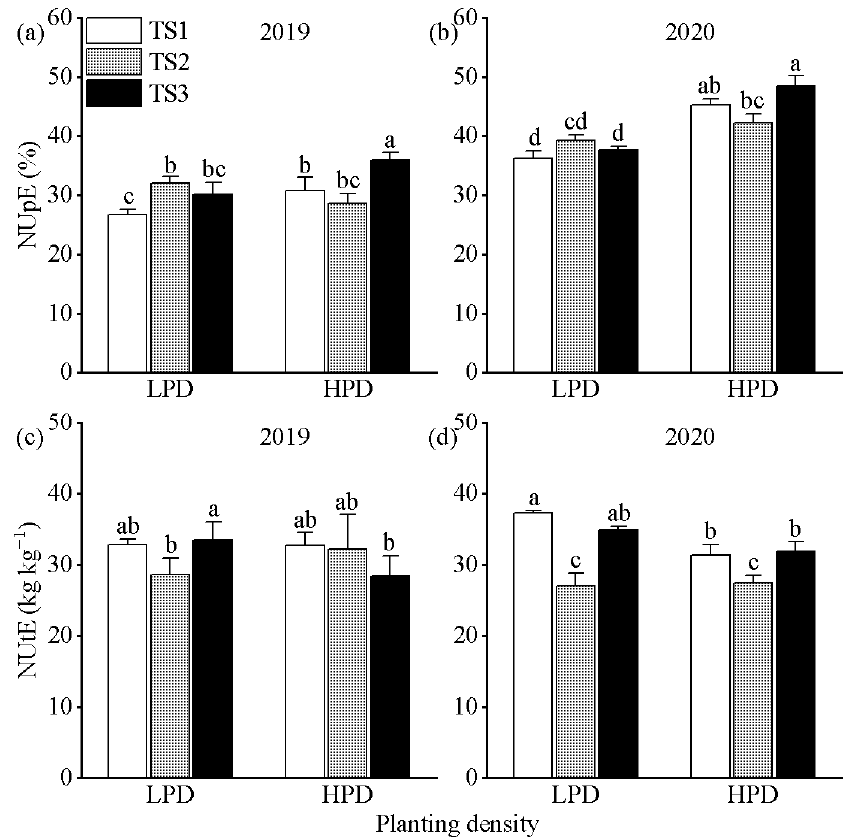
Figure 6. Effects of the combinations of planting density and method of tillage and sowing on ( a , b ) NUpE and ( c , d ) NUtE in the 2019 and 2020 seasons. Data are presented as means ± standard errors, and the bars above the columns are standard errors. The different letters on the bars indicate significant differences at the 0.05 probability level.